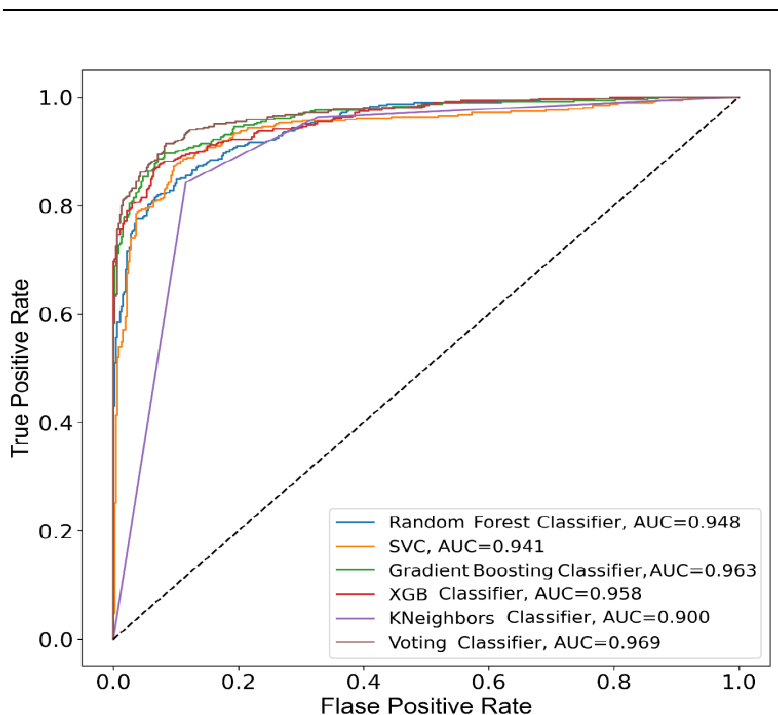
Figure 3. ROC – AUC curve of the proposed SVE method and the five classifiers. Figure 3. ROC–AUC curve of the proposed SVE method and the five classifiers. Moreover, the confusion matrix consists of two labels: label 0 represents the mild Table 6. Overall performance of all classifiers stage in which 466 patients were tested, with 423 correctly predicted and 43 incorrectly predicted; and label 1 represents the severe stage, in which 465 patients were tested, with 425 correctly predicted and 40 incorrectly predicted.